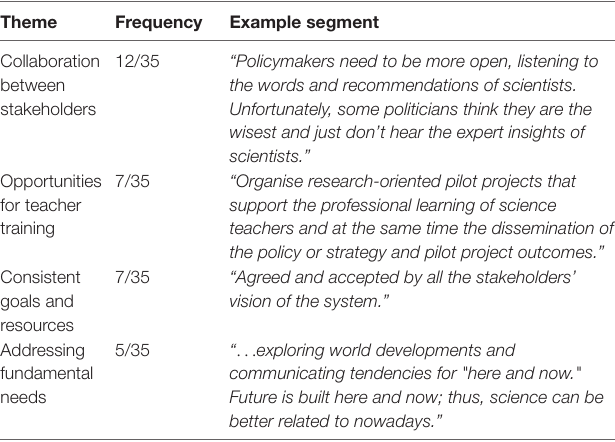
TABLE 2 | Absolute frequencies of themes and example segments regarding key components of effective